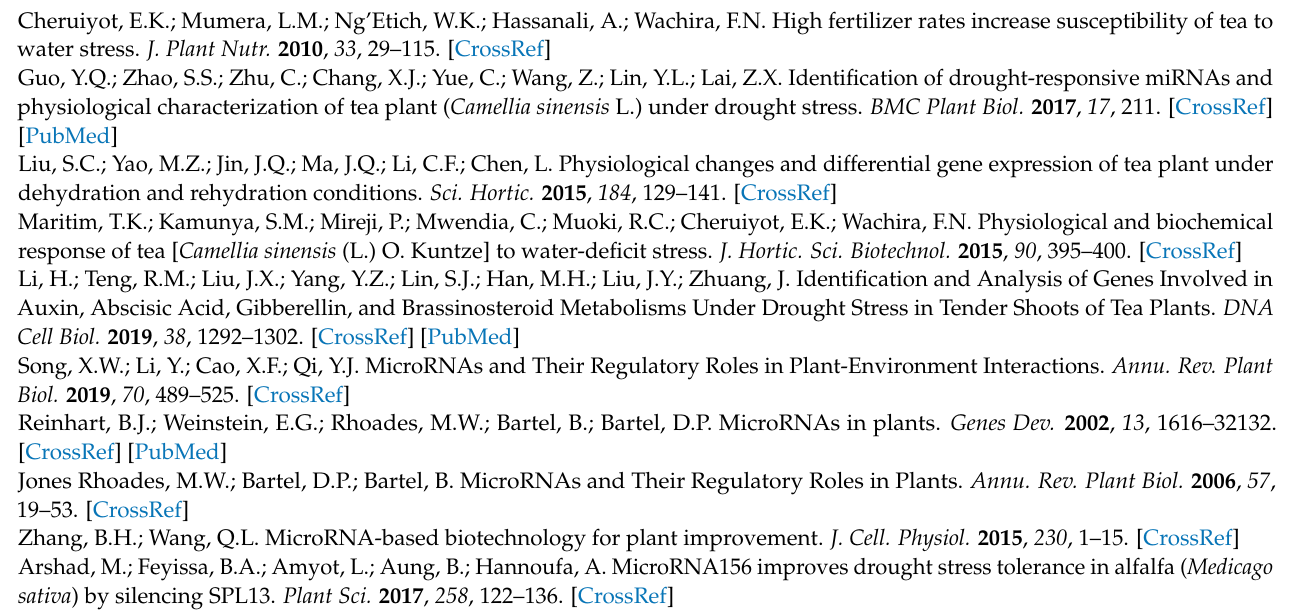
pre-miR166s, Table S3. Primers for RT-qPCR, Table S4. The location information of the pre-miR166s scaffold, Table S5. Prediction of the csn-miR166 target gene, Table S6. Naming information of csn- miR166 target gene, Table S7. The specific functions of different csn-miR166 members under the different drought